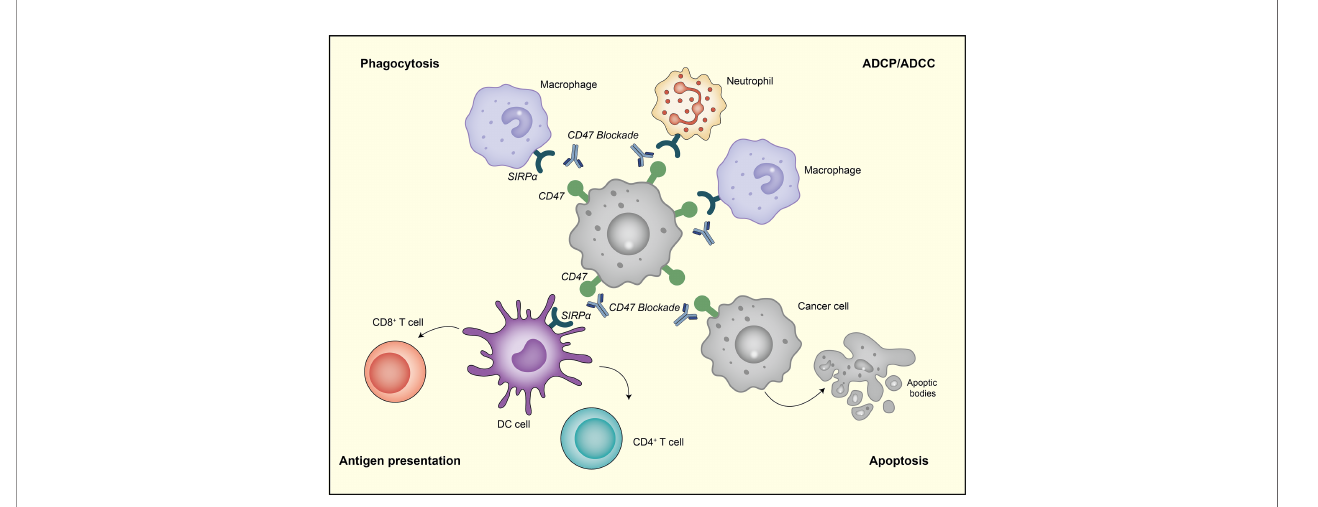
FIGURE 2 | The therapeutic targeting of CD47-SIRP a pathway can cause the elimination of breast cancer cells through the following four pathways. First, the inhibition of CD47-SIRP a could enhance tumor cell phagocytosis by macrophage. Second, anti-CD47 antibody enables the phagocytic uptake of tumor cells by dendritic cells and subsequent antigen presentation to CD4 + and CD8 + T cells, thereby stimulating anti-tumor adaptive immune response. Third, anti-CD47 antibody eliminates tumor cells via traditional Fc-dependent mechanisms, including ADCC and ADCP. Fourth, anti-CD47 antibody stimulates tumor cell apoptosis through a caspase-independent